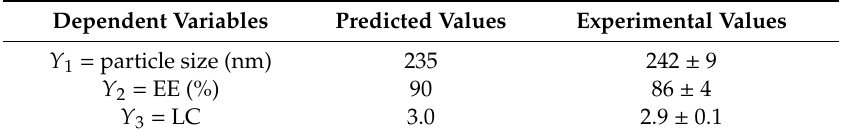
Table 4. Validation of the predicted optimal results with experimental values. (n =